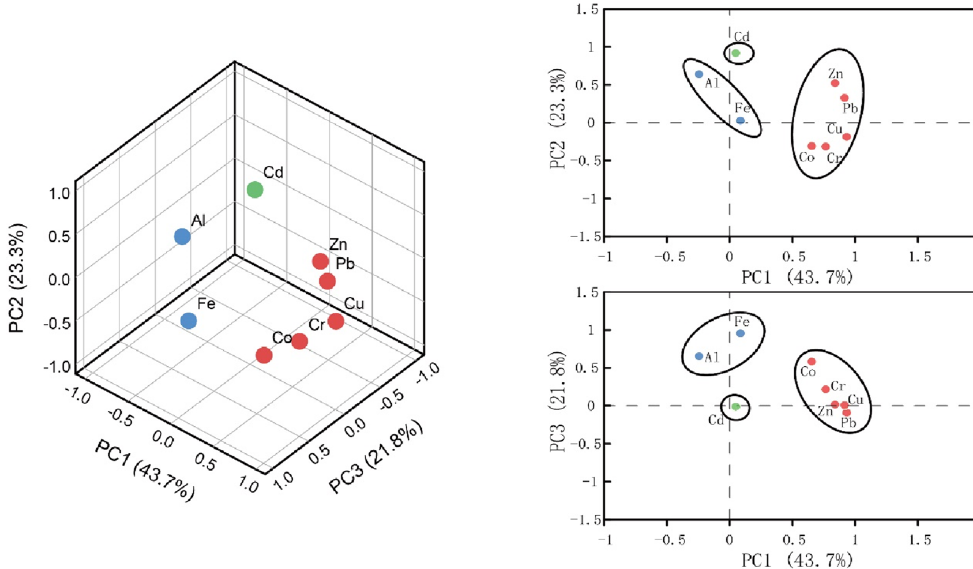
Figure 4. PCA results of the elements in the ED-D. Left: 3D loading plot of the elements; right: 2D loading plots on PC1–PC2 and